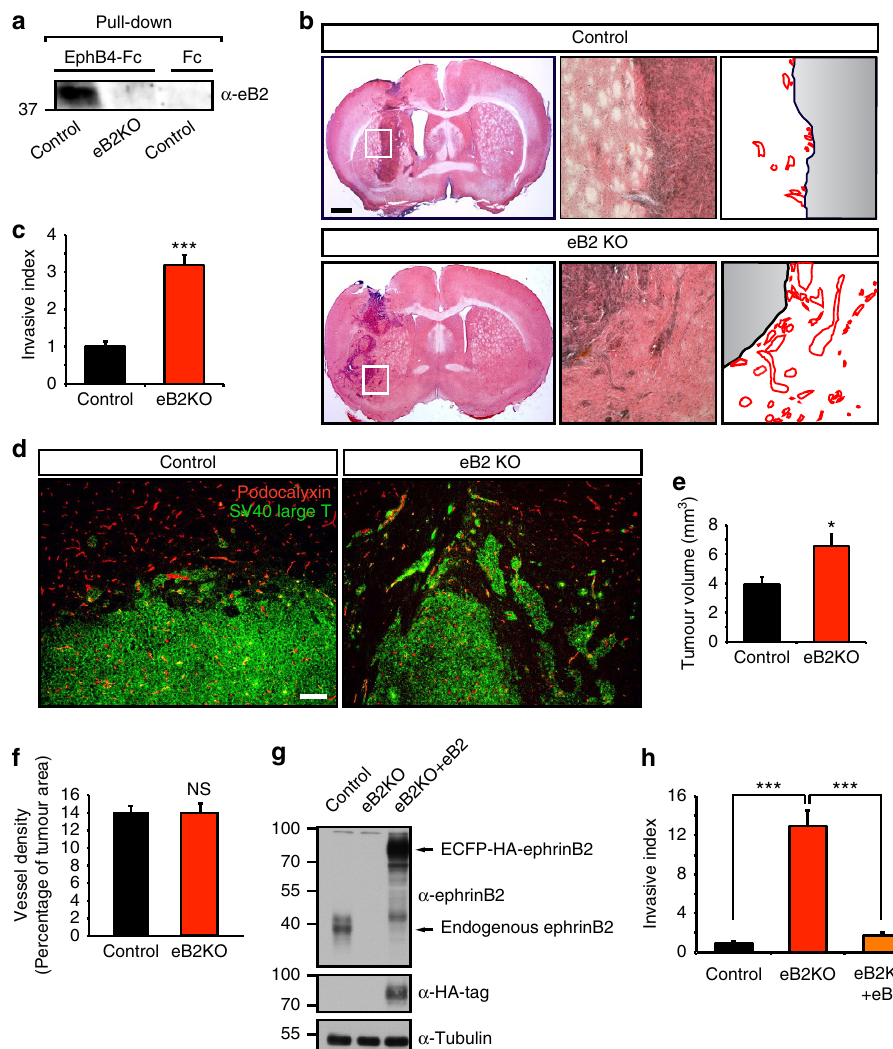
Figure 2 | Loss of ephrinB2 increases tumour invasiveness. ( a ) Generation of gliomas lacking ephrinB2. Immunoblot of ephrinB2 knockout (eB2KO) and wild-type gliomas following pulldown of ephrinB2 by EphB4-Fc. ( b , c ) Loss of ephrinB2 increases tumour invasion. Hematoxylin-eosin staining of intracranial control and ephrinB2 KO glioma xenografts (left) together with representative pictures of tumour rims (middle) and traces showing central tumour tissue (grey) at the interface to the brain parenchyma (black line) and the invading cells (red lines, right) ( b ). Quantification of the invasive index of control and ephrinB2 KO gliomas, assessed by measuring the area of tumour invading the brain parenchyma per tumour rim length ( n ¼ 5 tumours) ( c ). ( d ) Loss of ephrinB2 induces parenchymal invasion (right panel). Tumour cells are stained in green with anti-SV40 large T antigen, and endothelial cells in red with anti-podocalyxin. ( e ) Increased invasion is accompanied by increased tumour volume in ephrinB2-deficient tumours. Quantification of tumour volume in control and ephrinB2 KO gliomas ( n ¼ 10–11 tumours). ( f ) Tumour vessel density was not affected by loss of ephrinB2 in tumour cells. Quantification of vessel area in control and ephrinB2 KO gliomas ( n ¼ 8–10 tumours). ( g , h ) Re-introduction of ephrinB2 into ephrinB2 KO tumours reverts the pro-invasive phenotype. Levels of ephrinB2 assessed by immunoblot of control, ephrinB2 KO (eB2KO) and ephrinB2 KO glioma cells re-expressing exogenous ECFP-HA-ephrinB2 (eB2KO þ eB2), probed with anti-ephrinB2 ( g ). Quantification of the invasive index of control, ephrinB2 KO and ephrinB2 KO gliomas re-expressing ephrinB2 was performed as in c ( n ¼ 7–9 tumours) ( h ). Scale bars, 1mm ( e ), 100 m m ( g ). Data are means þ s.e.m. NS, not